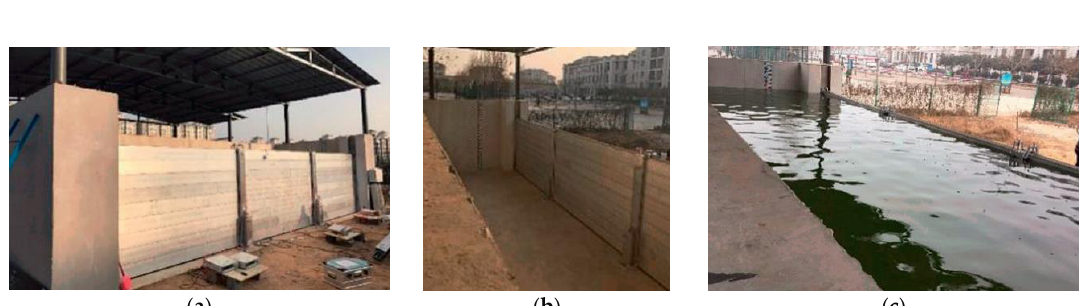
Figure 19. The view of the removable floodwall.